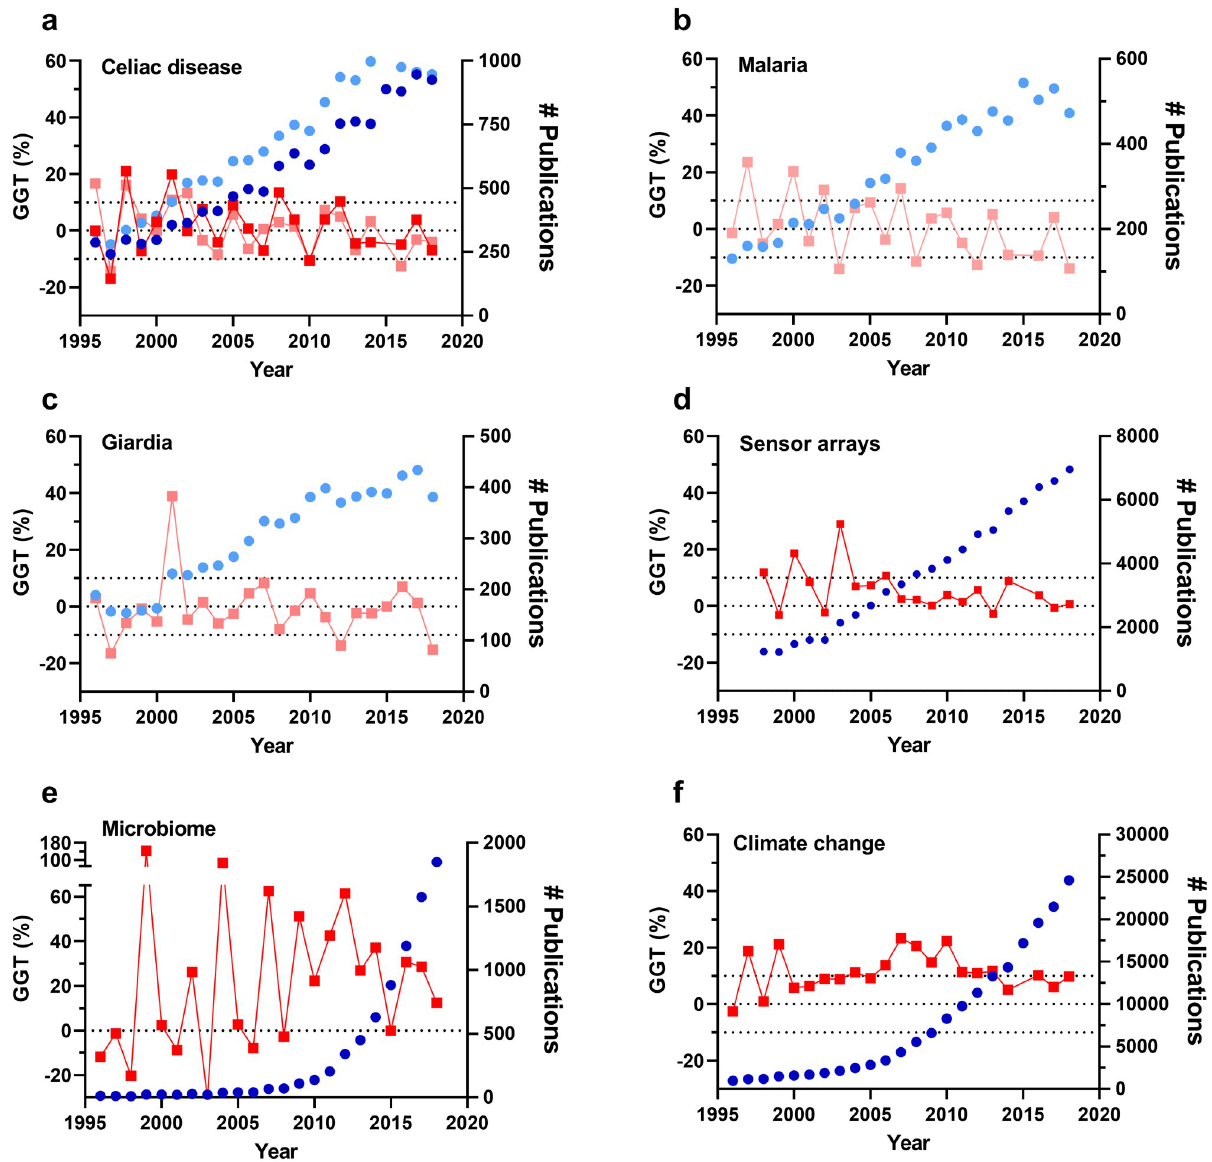
Fig 3. Trend analyses of publication trends derived from reviews. Fields analysed are: (a) celiac disease [17, 21], (b) Malaria [23], (c) Giardia [22], (d) sensor arrays [1], (e) microbiome [6] and (f) climate change [5]. All searches were conducted using keyword searches in the field section of WoS (dark colours) or PubMed (light colours). Search terms used were identical to those specified in the articles (see S1 File for specifications). The GGTs (dark and light red squares) are plotted on the left y-axes. The number of publications per year (dark and light circles) are plotted on the right